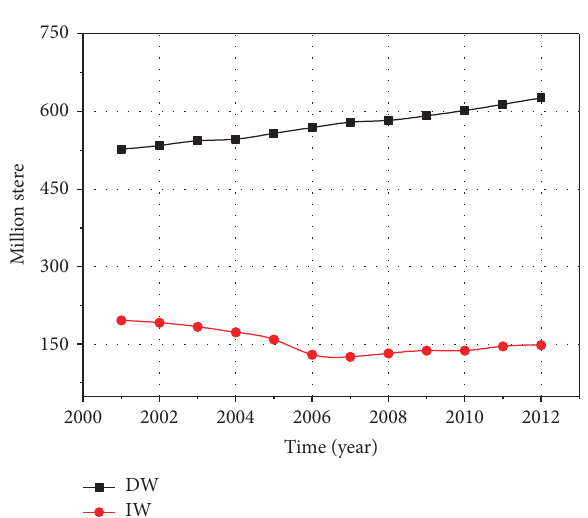
Figure 4: The comparison of wastewater treatment capacity and total wastewater.